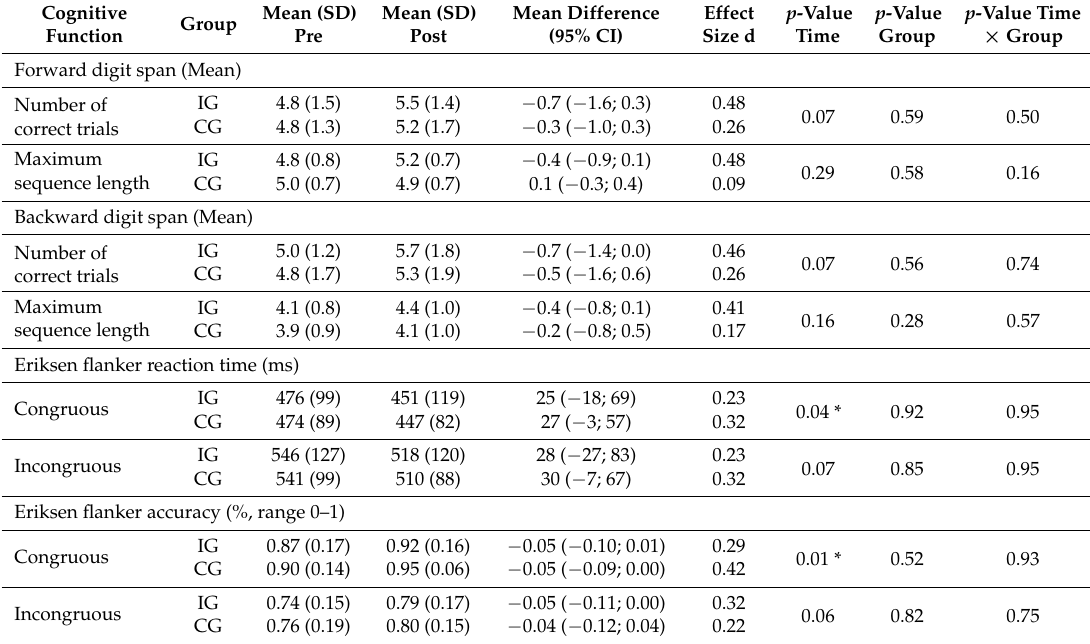
Table 3. Main results for the digit span task and Eriksen flanker task: Statistical values for IG and CG ( n =